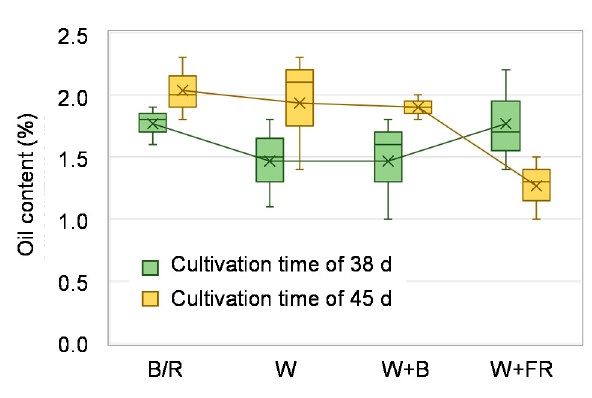
Figure 7. Essential oil content for dried leaves of marjoram plants grown under di ff erent LED treatments ( n = 9). Di ff erent letters in each column represents significant di ff erences between light treatments at p < 0.05, determined according to Tukey’s test. There was no significant di ff erence for both cultivation times, respectively.